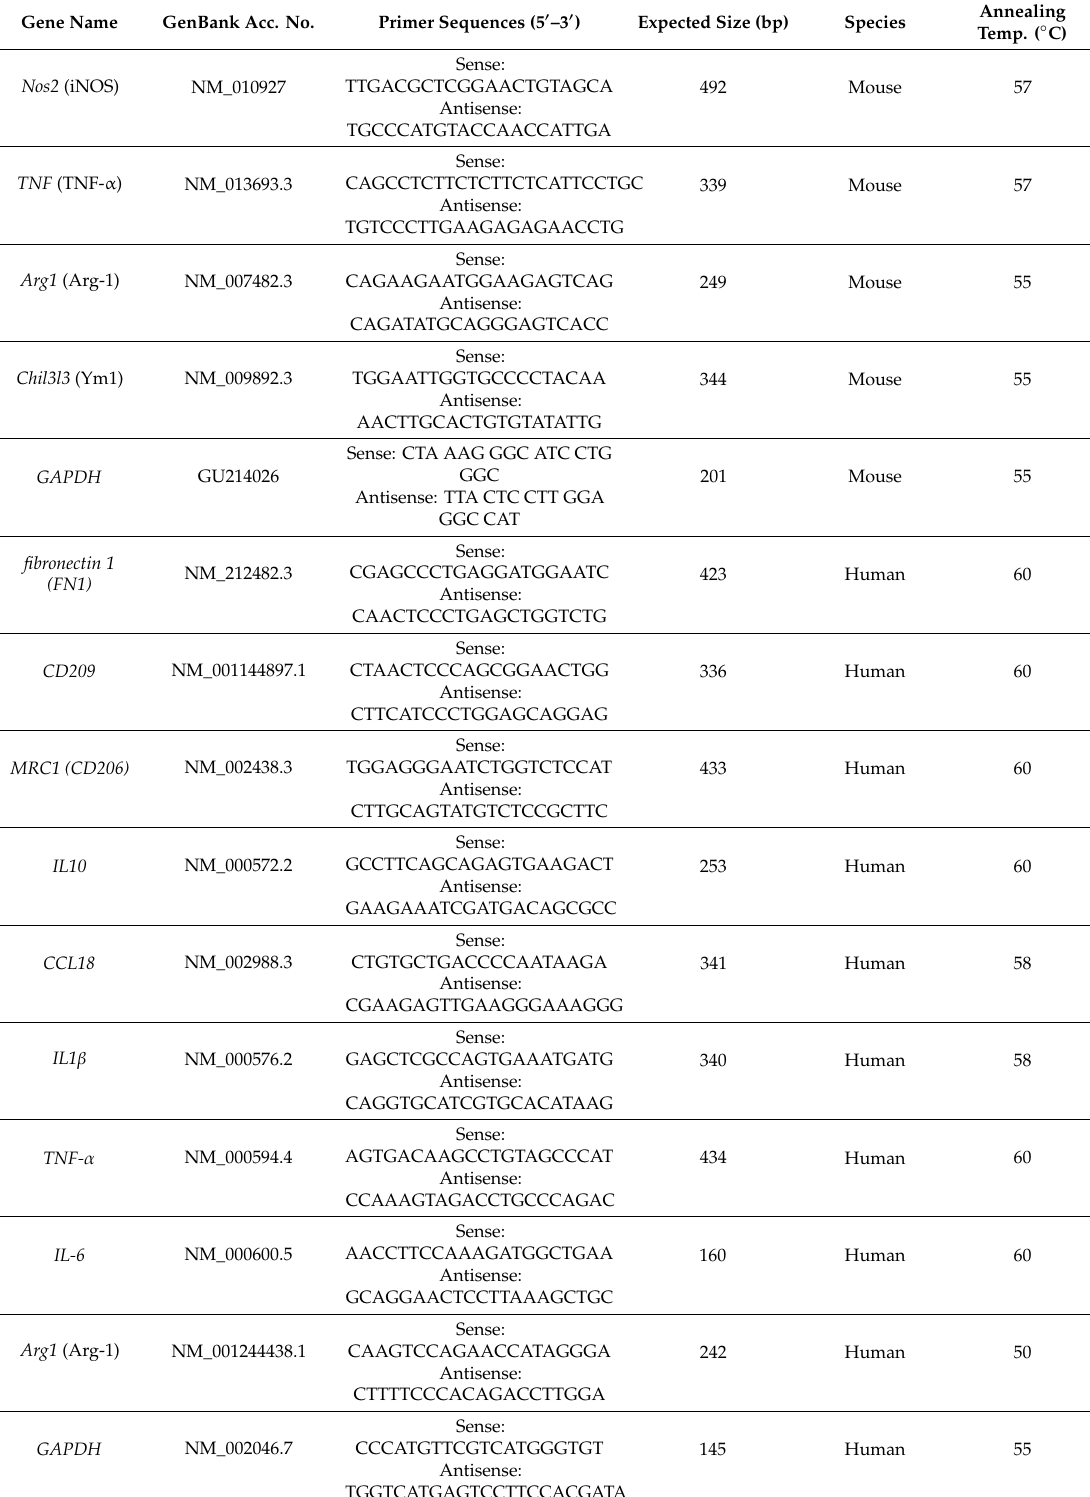
Table 1. Primer sequences used for